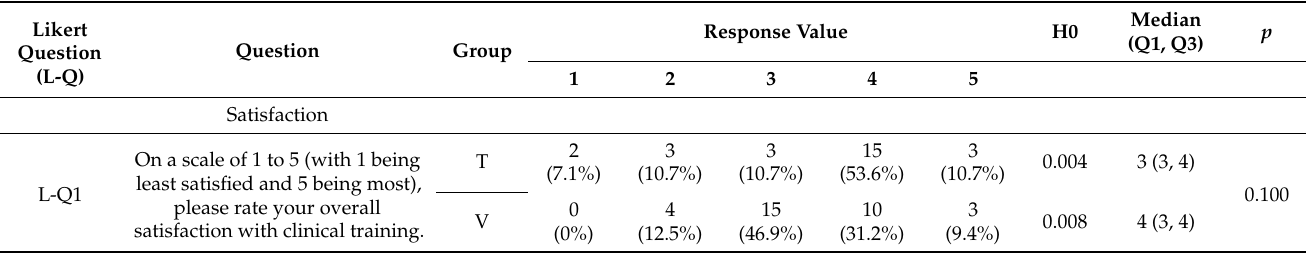
Table 1. Answers to the Likert questions. Statistical analysis and the number of participants for Group Traditional (T) and Group Virtual (V) are